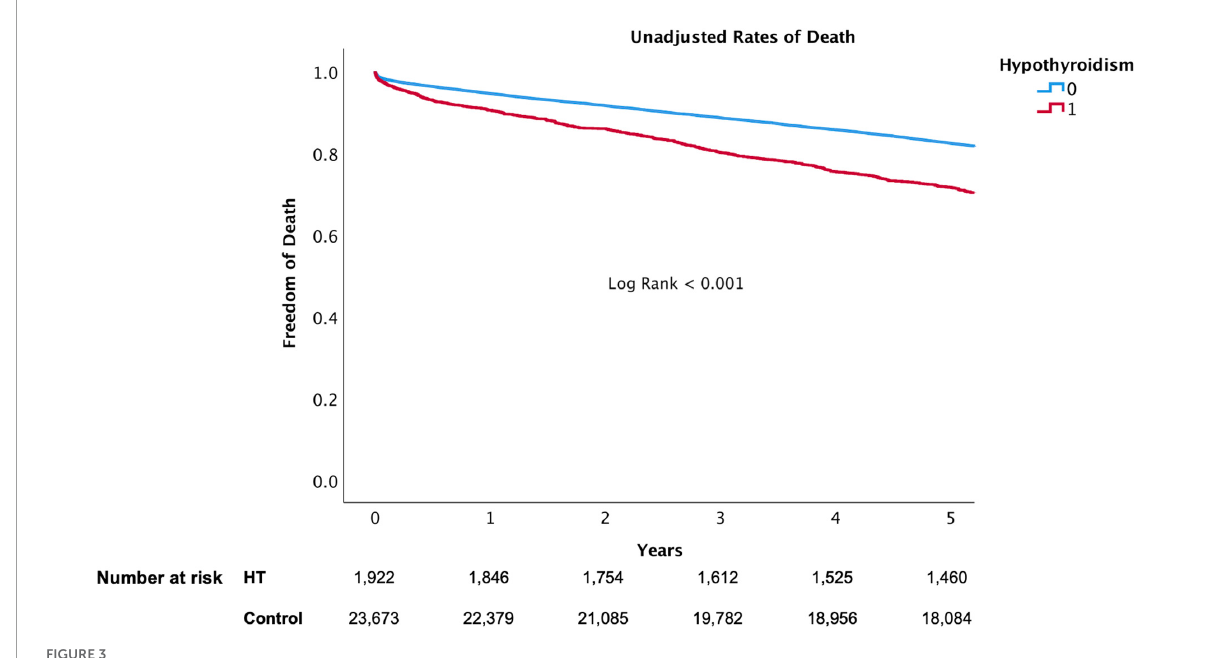
FIGURE3 5-Year all-cause mortality of hypothyroidism versus euthyroid patients.